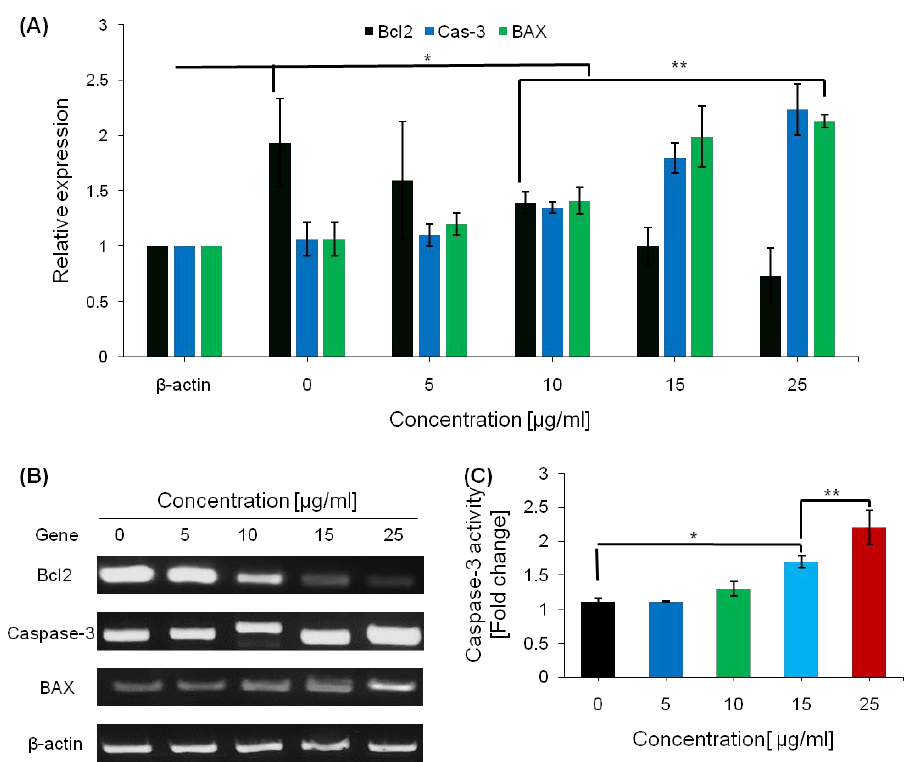
Figure 5. The effect of saponins on the induction of apoptosis in HEPG2 cells. ( A ) The effect of saponins on the expression of BAX and caspase-3 determined via RT-PCR. ( B ) Gel electrophoresis of the PCR products from the apoptosis promoting genes RT-PCR. ( C ). The effects of saponins on the activity of caspase-3 in HEPG2 cells were determined by a calorimetric analysis. The data are shown as the mean ± SEM from three independent experiments. * = p < 0.001, ** = p < 0.001 compared with the control.